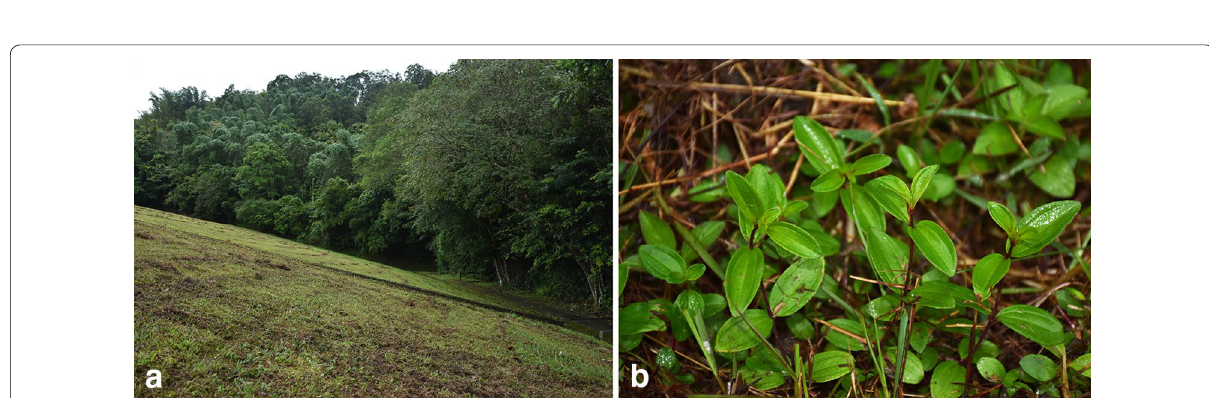
Fig. 6 Melastoma kudoi Sasaki. a Habitat; b plant individuals under intense human